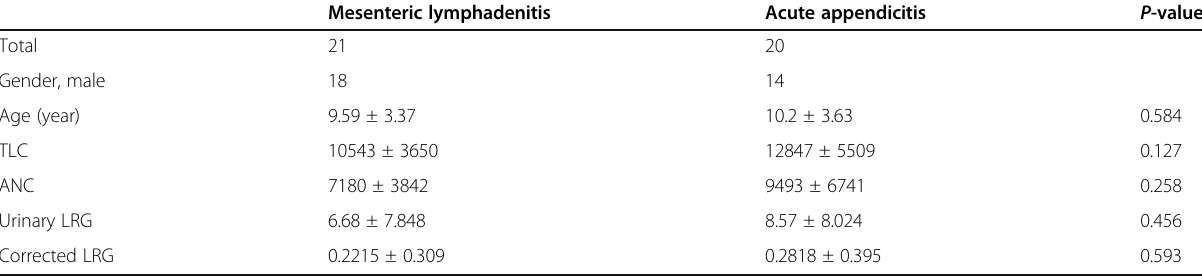
Table 1 Demography, blood, and urine test result of included children Mesenteric lymphadenitis